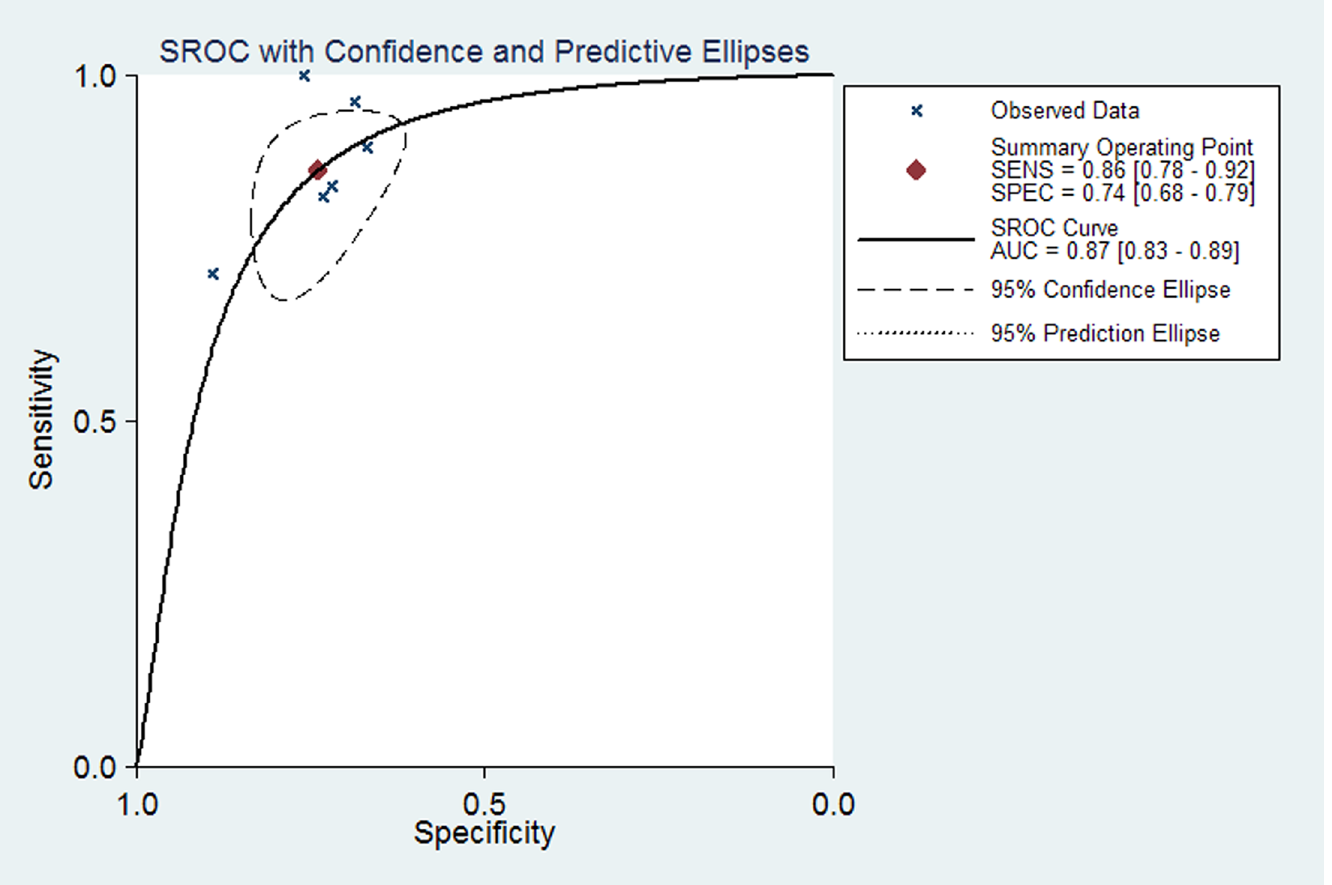
Fig 5. SROC curves for 6 studies of live stiffness measured by TE to predict the overall postoperative complications.